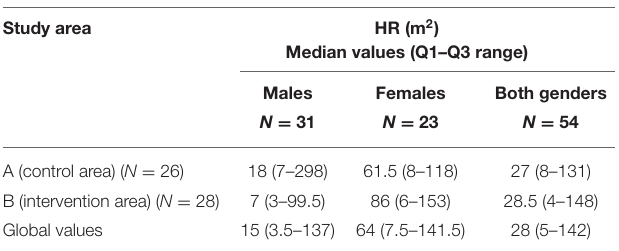
TABLE 2 | Home range (HR) values of dogs captured/recaptured at least three times in two areas of Divinópolis, Minas Gerais, Brazil, within the